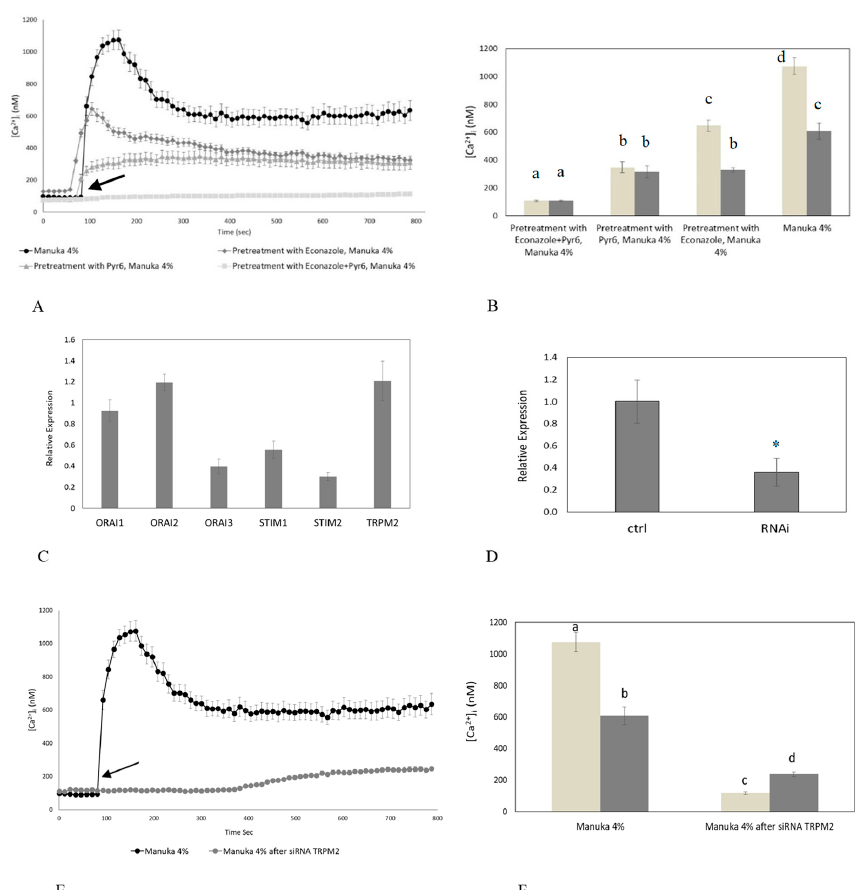
Figure 4. The inhibition of TRPM2 and Orai1 channels abolishes manuka honey-induced Ca 2+ entry. ( A ) Manuka honey-induced Ca 2+ entry was dramatically reduced in the presence of either 10 µM Econazole or 1 µM Pyr6 (30 min preincubation for each drug) and completely abolished by the simultaneous treatment with both drugs. Manuka honey was added at 4% v / v . The arrow indicates the addition of manuka honey after 60 s. Data are presented as means ± SEM of [Ca 2+ ] i traces recorded in different cells. Number of cells: manuka honey: 40 cells from 3 exp; manuka honey + Econazole 10 µM: 50 cells from 3 exp; manuka honey + Pyr6 1 µM: 50 cells from 3 exp; manuka honey + Econazole 10 µM + Pyr6 1 µM: 50 cells from 3 exp. ( B ) Mean ± SEM of the Ca 2+ response to 4% v / v manuka honey recorded at the peak (light bars) and at the plateau (dark bars) under the designated treatments. Data are presented as means ± SEM of [Ca 2+ ] i measured by confocal imaging at peak maxima. Number of cells as in ( A ). Different letters above the bars indicate statistical difference determined by Two-way ANOVA with Bonferroni’s correction ( p < 0.01). ( C ) The mRNA quantity of Stim1-2, Orai1-3 and TRPM2 transcripts was determined by qRT-PCR and is represented as mean relative expression ± SD ( n = 3). ( D ) Expression of TRPM2 gene in HaCaT cells after RNAi. The mRNA quantity of TRPM2 was determined by qRT-PCR and is represented as mean relative expression ± SD ( n = 3, * p < 0.001, t -test). ( E ) The Ca 2+ response to 4% v / v manuka honey was suppressed in HaCaT cells transfected with a RNAi selectively targeting TRPM2. The arrow indicates the addition of manuka honey after 60 s. Data are presented as means ± SEM of [Ca 2+ ] i traces recorded in different cells. Number of cells: manuka honey: 40 cells from 3 exp; manuka honey after RNAi for TRPM2: 40 cells from 3 exp. ( F ). Mean ± SEM of the Ca 2+ response to 4% v / v manuka honey recorded at the peak (light bars) and at the plateau (dark bars) under the designate treatments. Number of cells as in ( E ). Different letters above the bars indicate statistical difference determined by two-way ANOVA with Bonferroni’s correction ( p < 0.01). Likewise, Pyr6 (1 µ M, 30 min), a selective inhibitor of Orai1 channels, caused a significant decrease of both phases of manuka honey-induced elevation in [Ca 2+ ] i (Figure 4A,B). As Pyr6 selectively